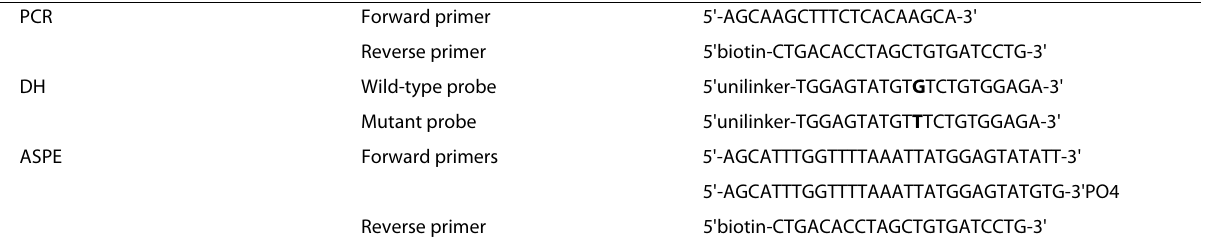
Table 1: Primers and probes used in end point PCR, ASPE and DH reactions.